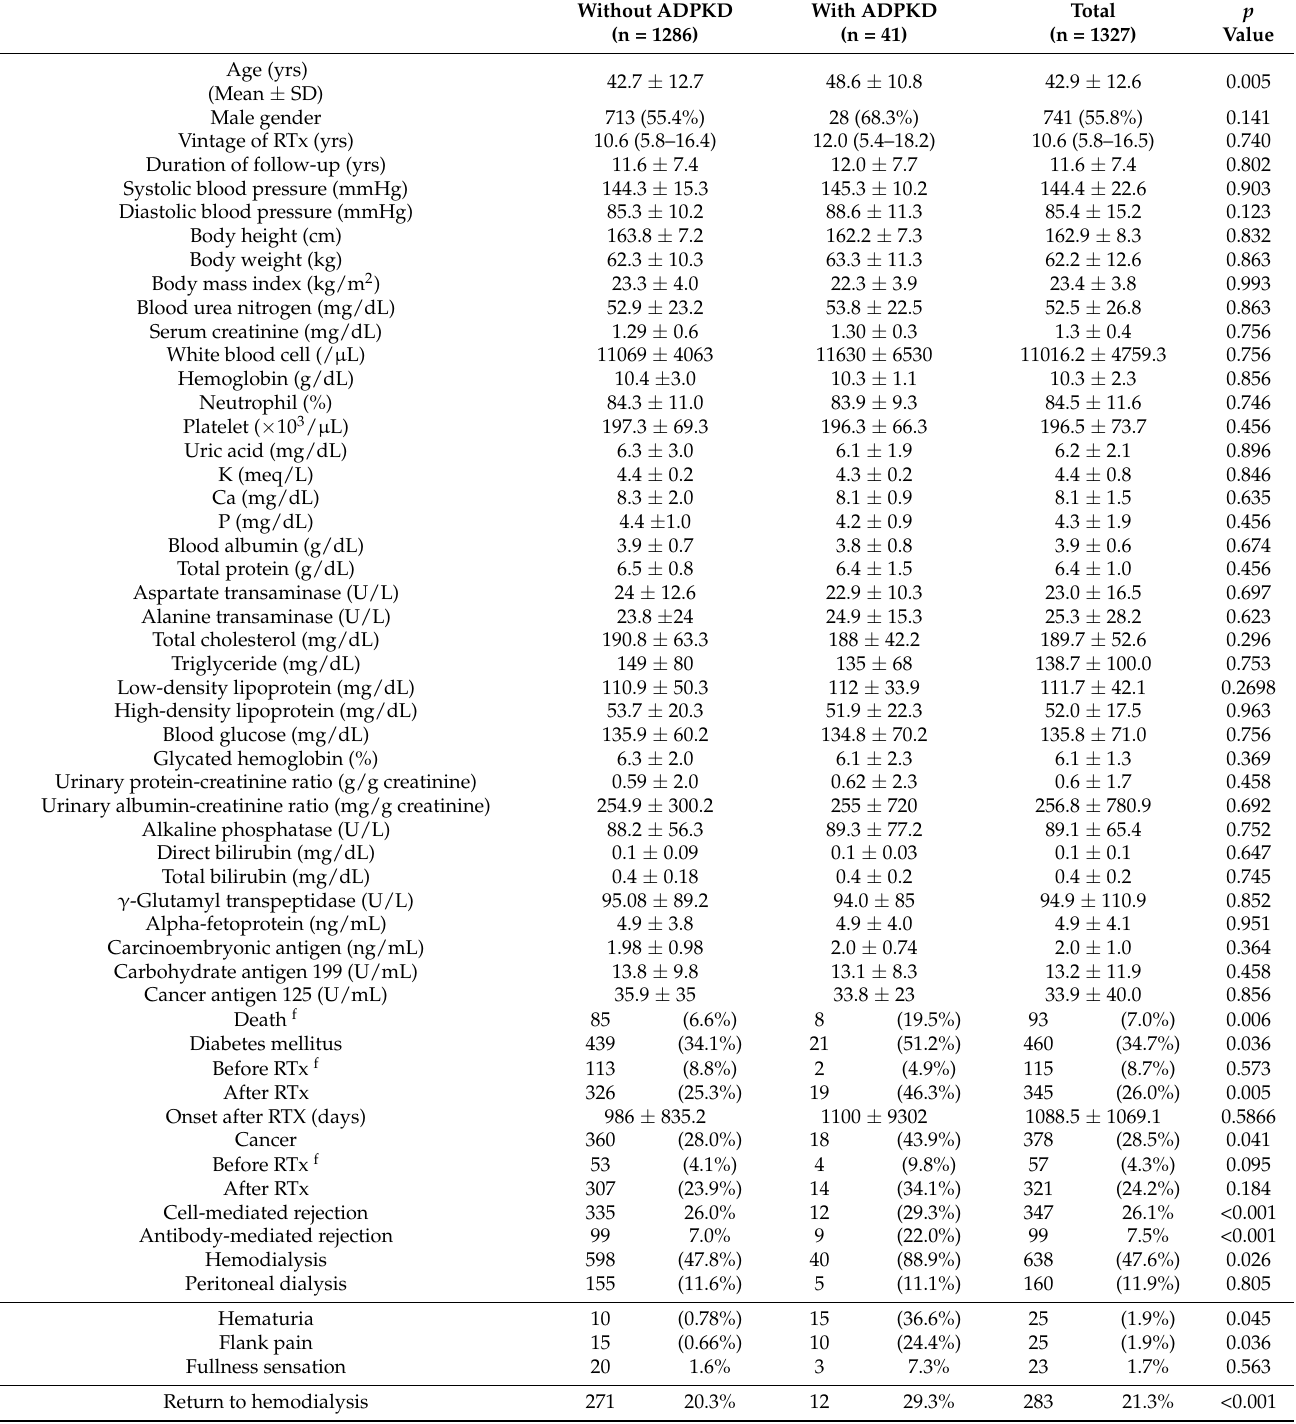
Table 1. Baseline characteristics of renal transplantation recipients according to ADPKD or not